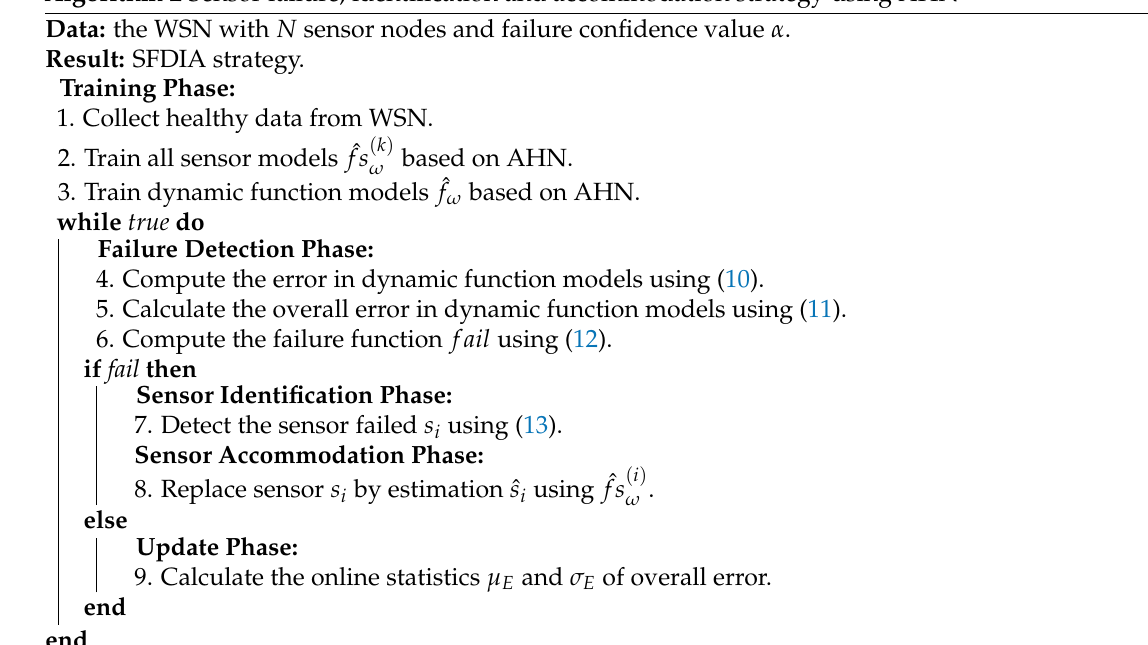
Algorithm 2 Sensor failure, identification and accommodation strategy using